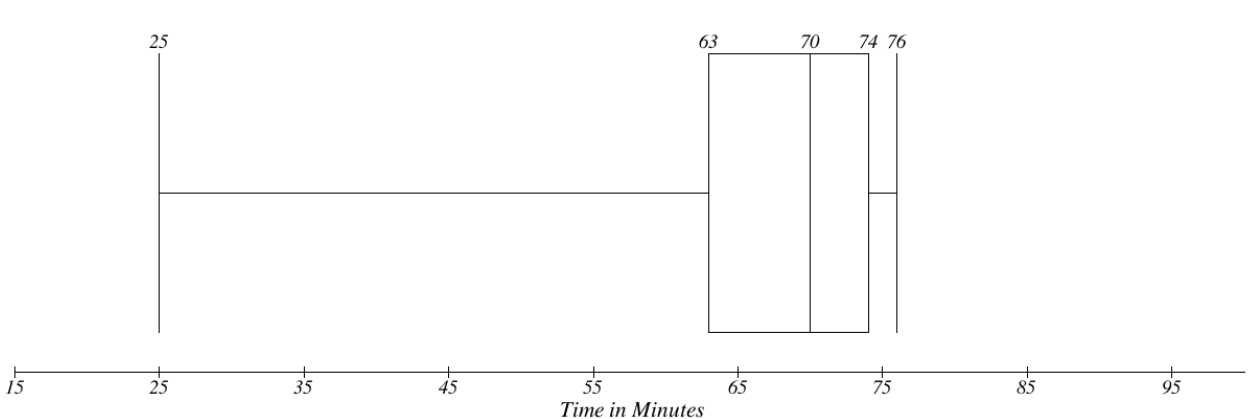
Figure 10. Overall time needs in traditional concept.